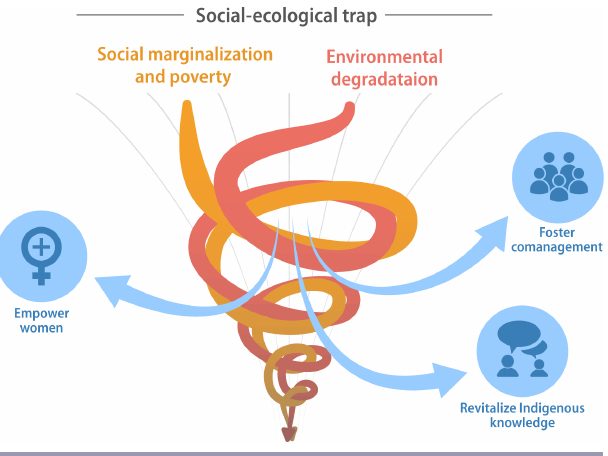
Fig. 1 . Three pathways for disrupting social-ecological traps highlighted by the papers in this Special Feature: (1) revitalize Indigenous knowledge and stewardship, (2) foster comanagement, and (3) empower